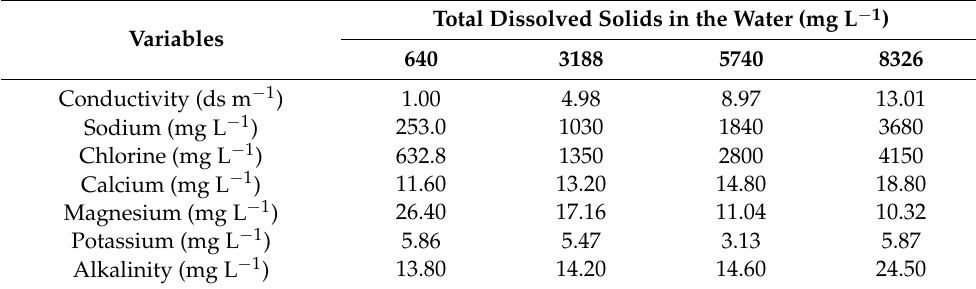
Table 2. Mean values of the conductivity variables, total dissolved solids (sodium, chlorine, calcium, magnesium, and potassium), and alkalinity of the waters offered to the experimental